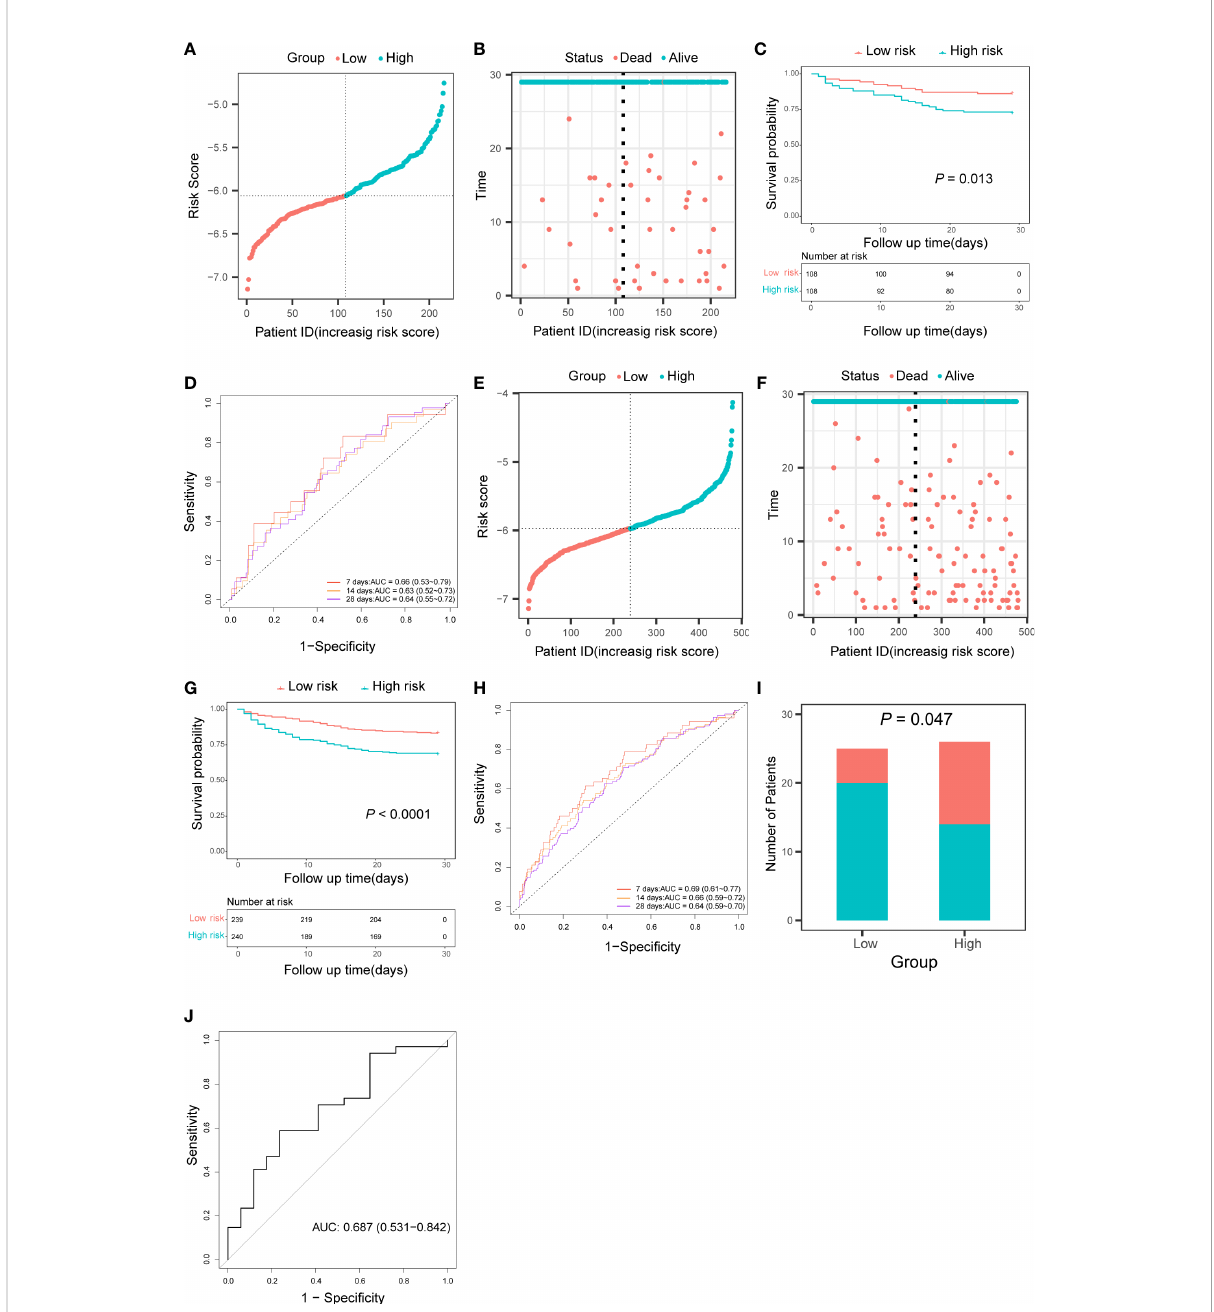
FIGURE 4 Validation of the pyroptosis-related prognostic risk score in the validation cohort, the test cohort, and the GSE95233 cohort. (A, E) Distribution of patients based on the risk score in the validation cohort (A) and the test cohort (E) . (B, F) Survival time and status of patients in the validation cohort (B) and the test cohort (F) . (C, G) Kaplan-Meier curves analysis for the survival of patients in low- and high-risk groups in the validation cohort (C) and the test cohort (G) . (D, H) Time-dependent receiver operating characteristic curve for 7-, 14-, and 28-day survival of patients in the validation cohort (D) and the test cohort (H) . (I) The survival of patients in low- and high-risk groups in the GSE95233 cohort. (J) Receiver operating characteristic curve for 28 days survival of patients in the GSE95233